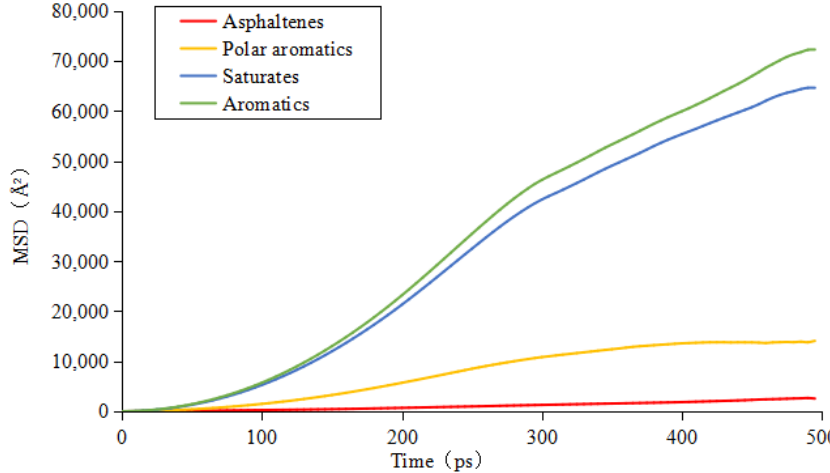
Figure 8. MSD of each component.